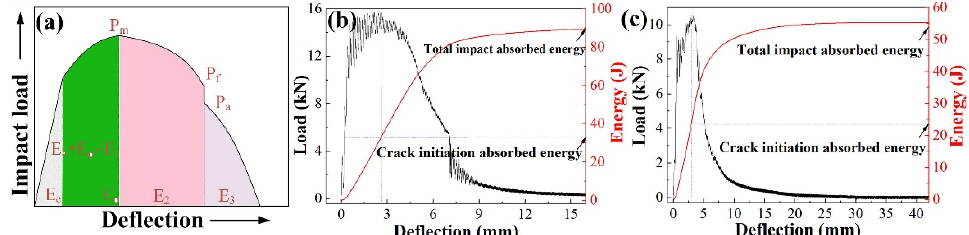
Figure 7. Schematic diagram ( a ) and deflection–load curves of the impact test specimen in steel A and B ( b , c ). and B ( b , c